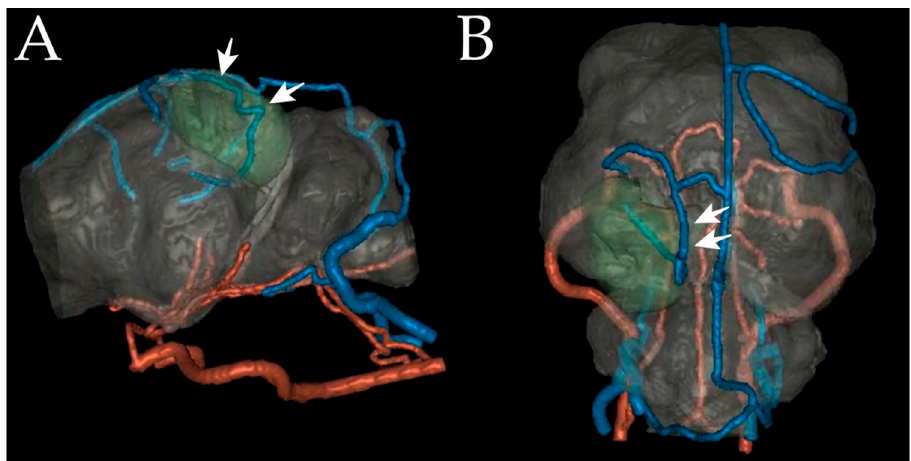
Figure 3. Virtual reconstruction images of the left lateral ( A ) and top view ( B ). The meningioma, depicted as green, is surrounded by the caudal meningeal vein (arrows).